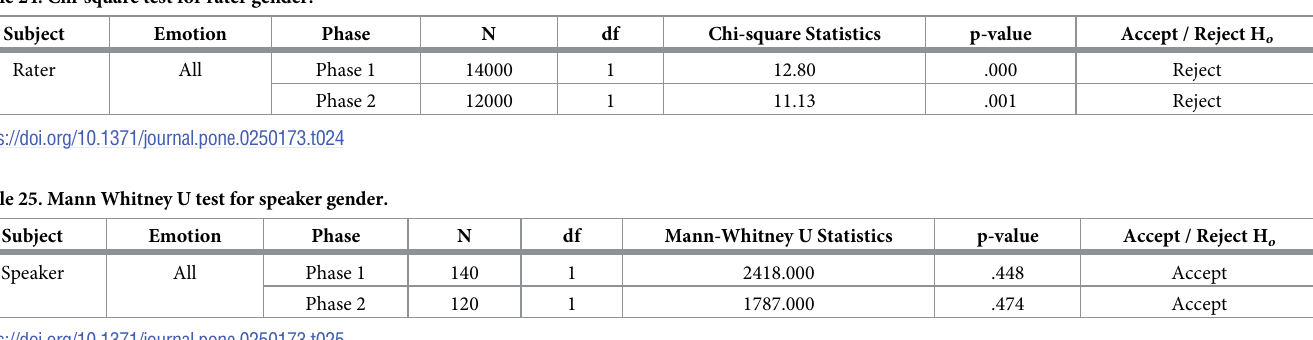
Table 24. Chi-square test for rater gender.